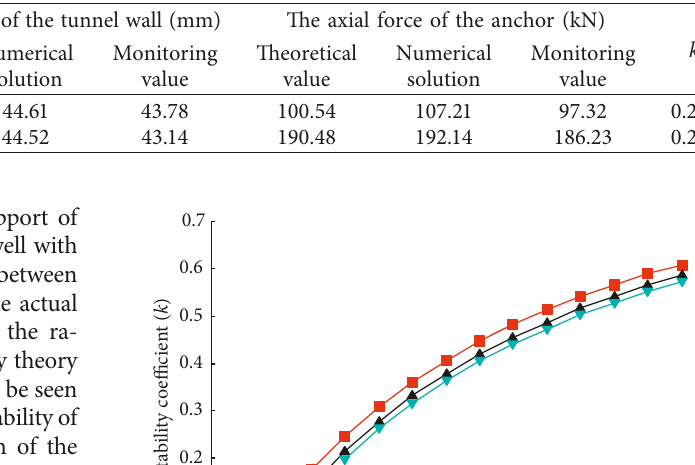
Table 4: Comparison of results.